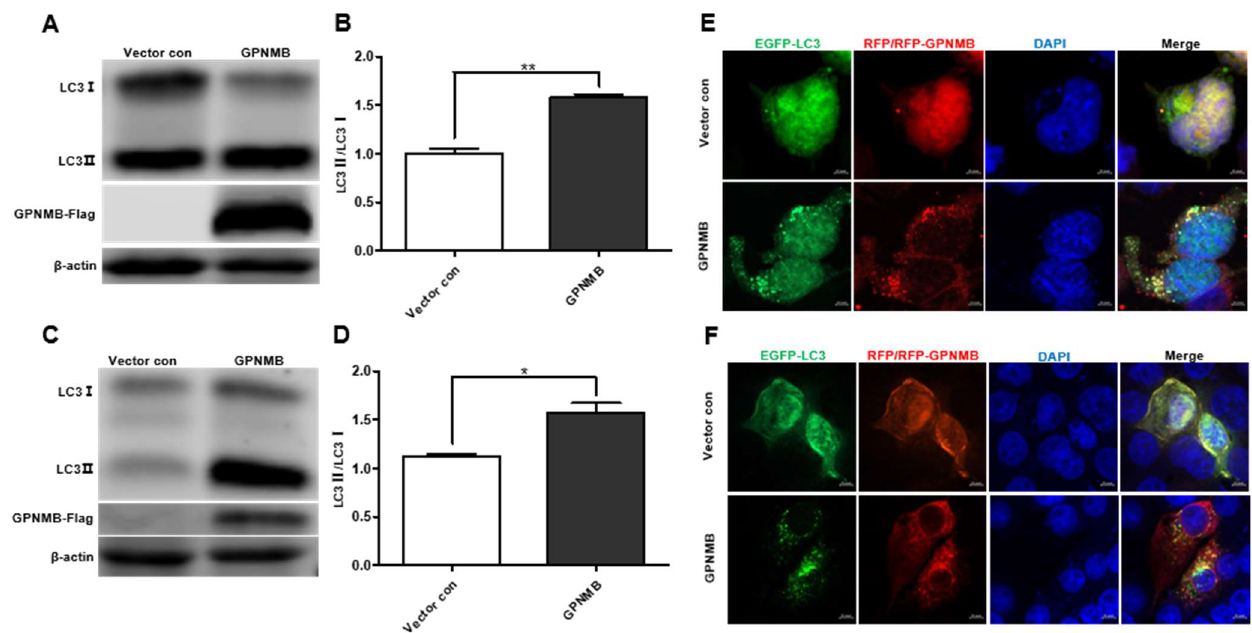
Figure 4. The formation of autophagosomes is induced by GPNMB. ( A – D ) LC3 protein conversion. HEK293T cells ( A , B ) and immortalized PAMs ( C , D ) were transfected with GPNMB-Flag; and then harvested and lysed. Extracts were analyzed by Western blot using an anti-LC3 antibody. The ratio of LC3II/LC3I reflects the level of autophagy. ( E , F ) EGFP-LC3 and RFP-GPNMB were co-transfected into HEK293T ( E ) and immortalized PAMs ( F ). Twenty-four hours after transfection, cells were harvested and visualized under a fluorescence microscope. Nuclei were stained with DAPI. * p < 0.05; ** p < 0.01. The p -value was calculated using Student’s t -test.